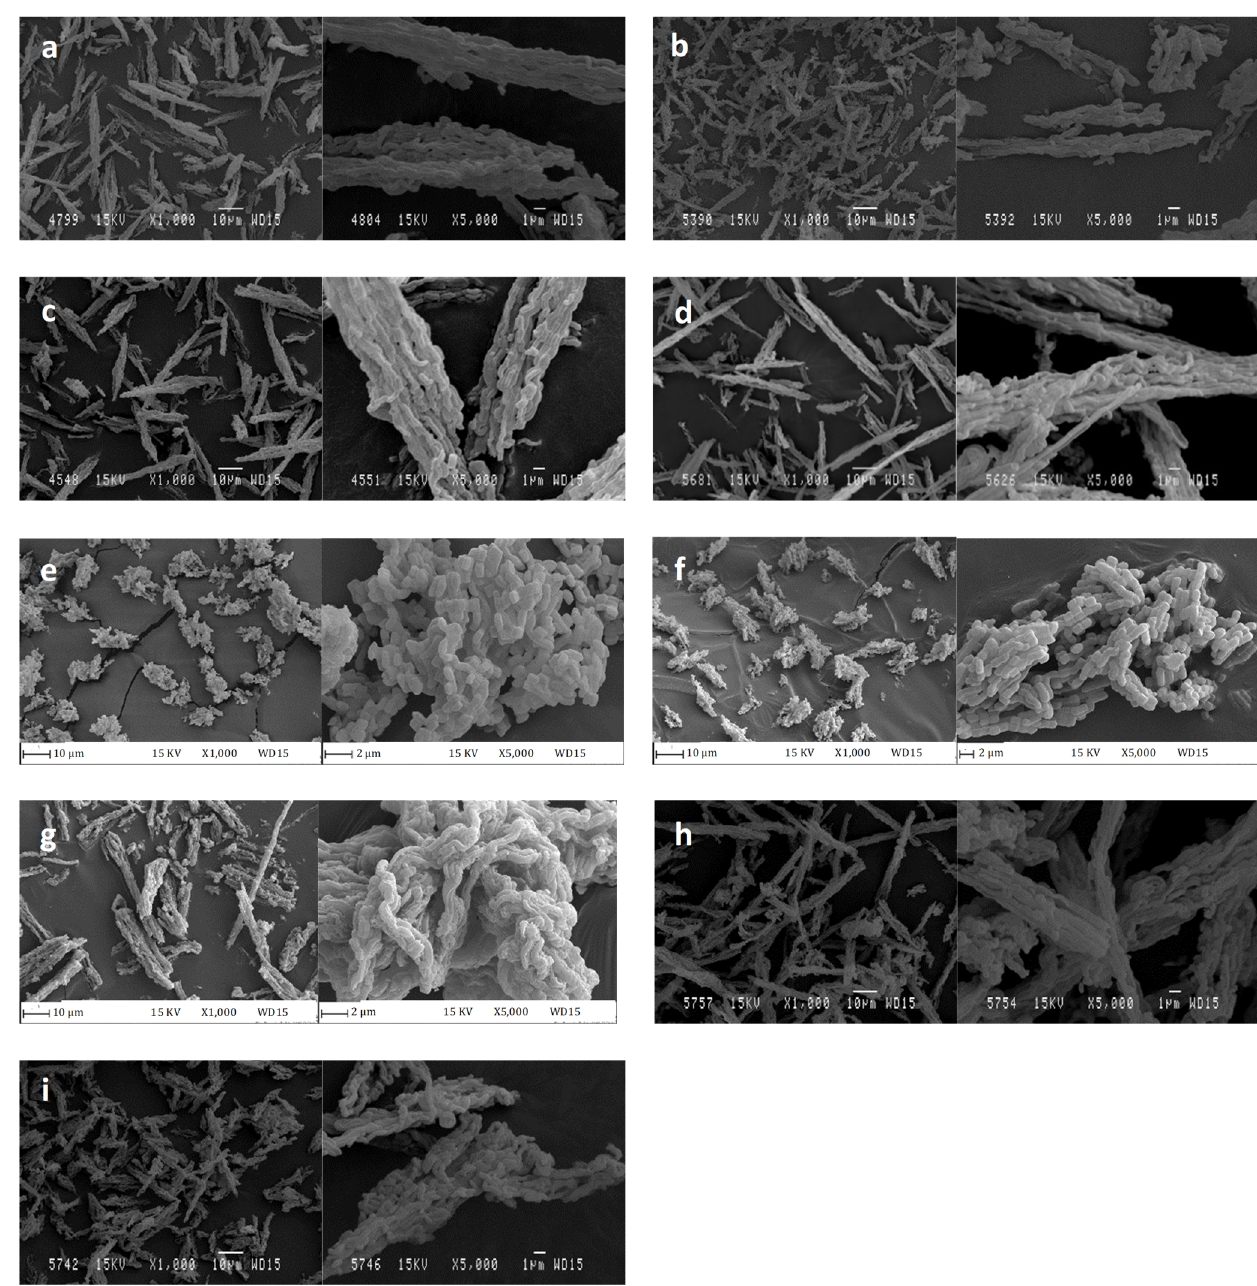
Figure 7. SEM micrographs of the synthesized SBA-15 catalyst: ( a ) t6, ( b ) t15, ( c ) t20, ( d ) t24 (also named samples T40 and R700), ( e ) T25, ( f ) T30, ( g ) T55, ( h ) R400, and ( i ) R1000 at two different magnifications.